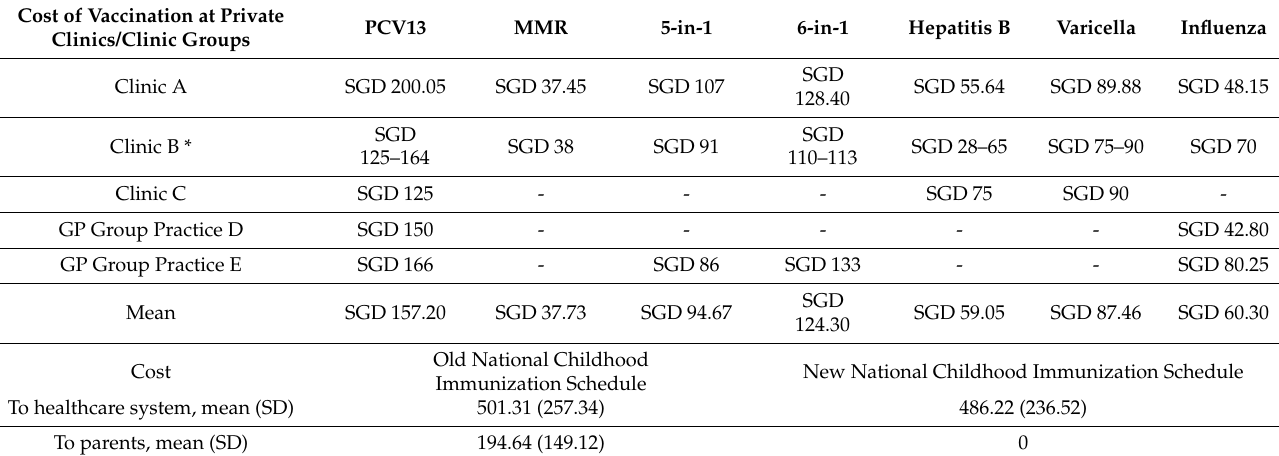
Table 4. Calculation of vaccine cost and cost distribution for both groups of NCIS